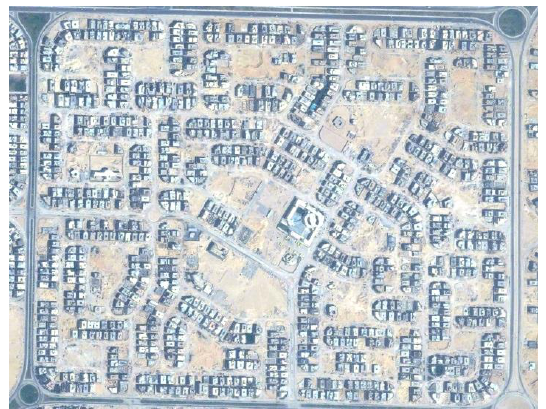
Figure 2. Satellite image for the third district (neighborhood scale of about 1 km 2 ) of the fifth community, case no.1 (sub-urban).